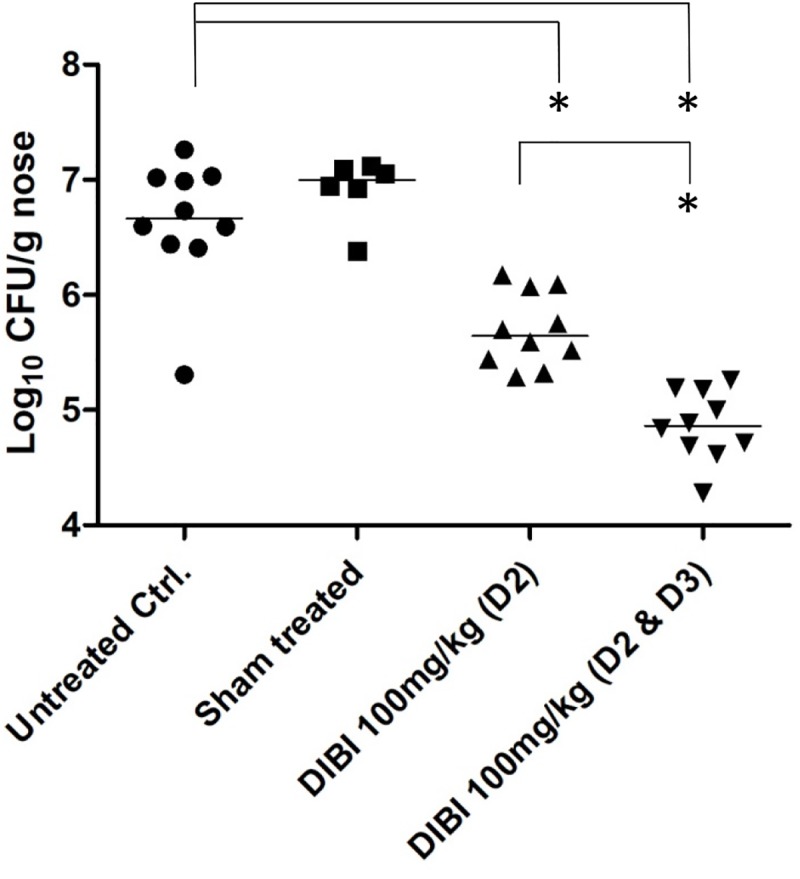
DIBI reduces S. aureus nares carriage. Mice were infected intranasally with S. aureus ATCC43300 at day -2 and day 0. At day 2 PI mice were treated intranasally with PBS-vehicle or with DIBI at 100 mg/kg. Groups of mice that had been treated with DIBI at day 2 PI were also treated at day 3 PI. Mice were sacrificed at day 5 PI and quantitative determinations of CFU/g nares were completed by plate counting. The log10 of bacterial counts (CFU/g nares) are graphed with their median value. Carriage burden of treatment groups were compared to non-treated infected controls; (∗) significant with p < 0.05.